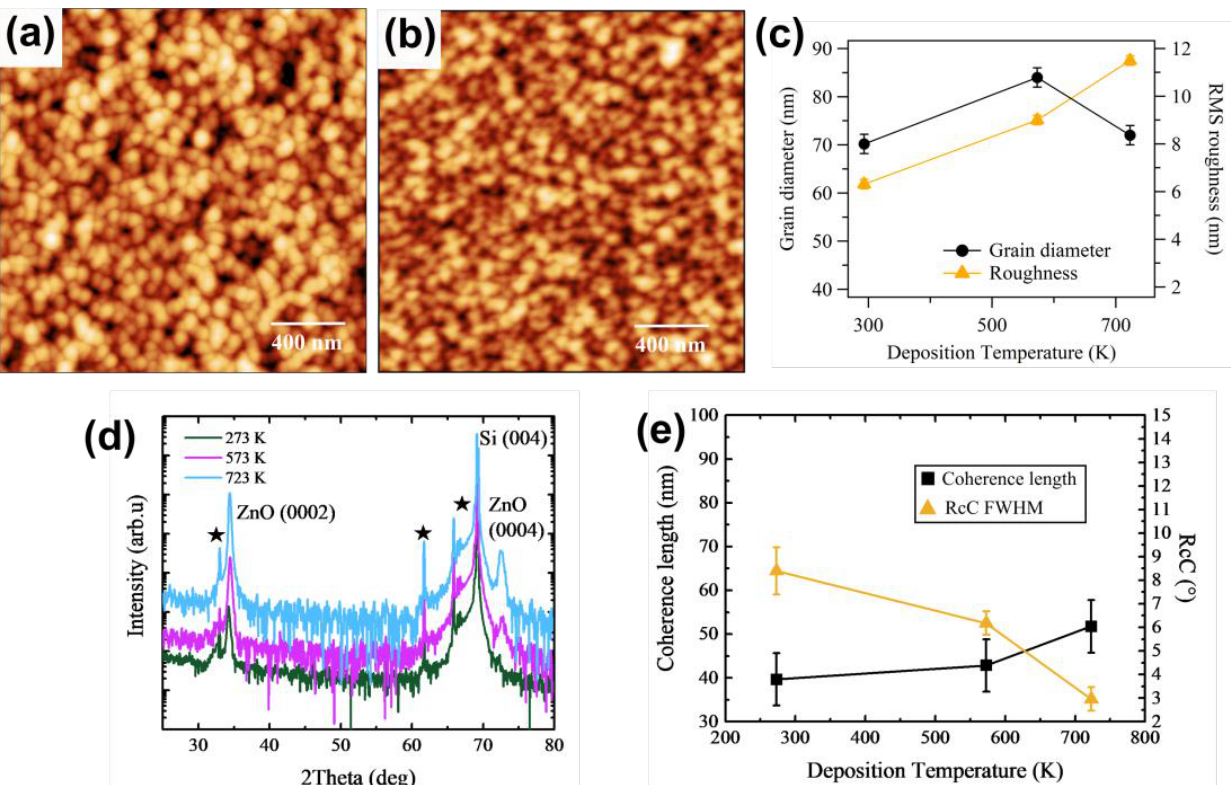
Figure 2. AFM images of size 2 × 2 µ m 2 of 300 nm ZnO deposited at ( a ) 573 K and ( b ) 723 K in 100% Ar. ( c ) Average grain diameter (black dot) and RMS roughness (orange triangle) as obtained by grain analysis of AFM images of surfaces as a function of deposition temperature. ( d ) XRD plots, ( e ) coherence length (black squares) and rocking curve FWHM (orange triangles) for increasing deposition temperature. The XRD signals are vertically shifted to better observe the peaks.